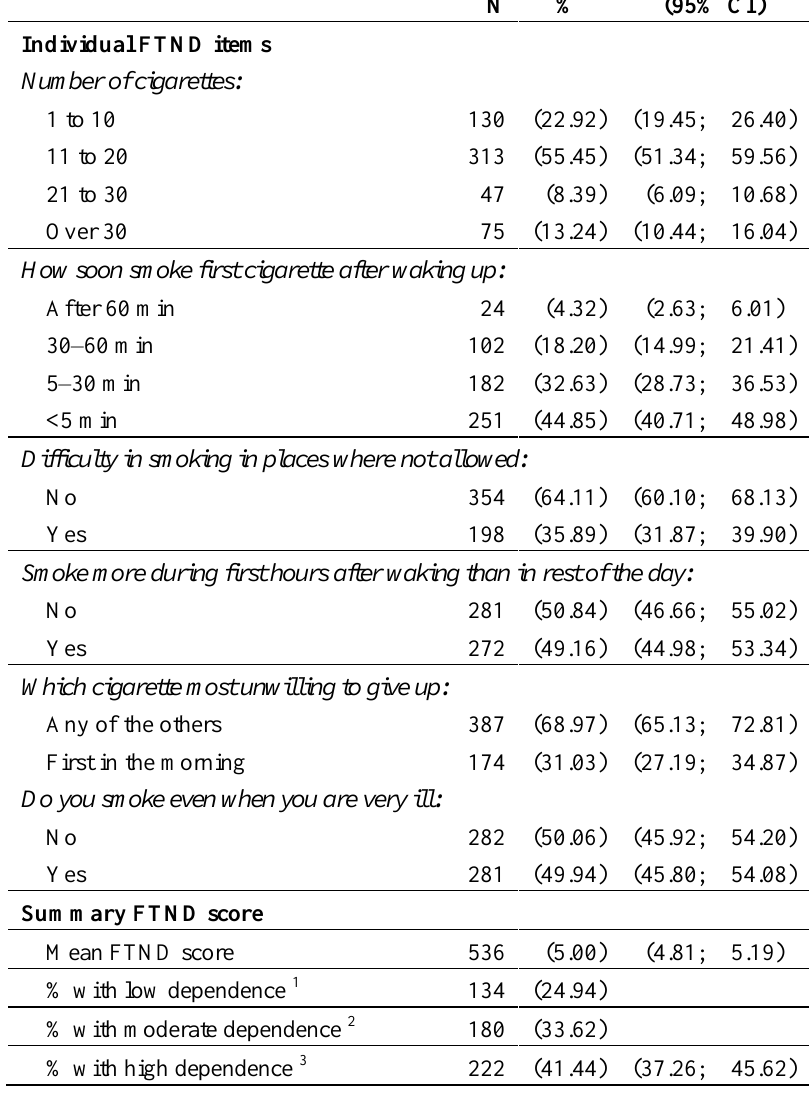
Table 2. Results of individual FTND items and the mean and categorical FTND scores (male current smokers only, N =